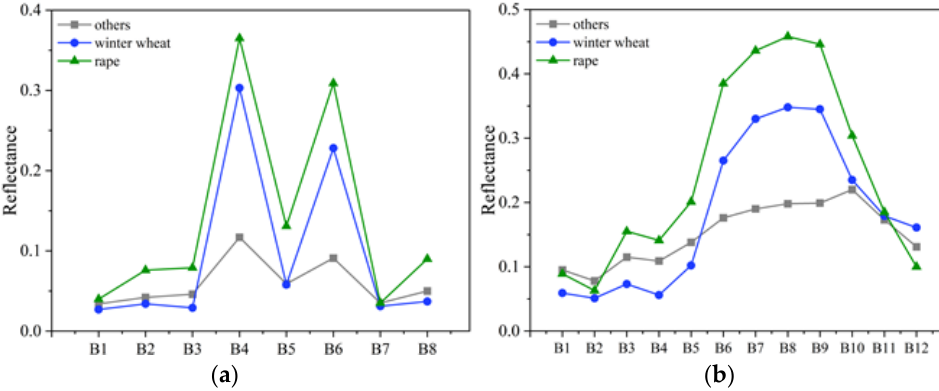
Figure 7. Analysis of spectral reflectance curves of various classes in ( a ) GF-6 WFV and ( b ) Sentinel-2A data.